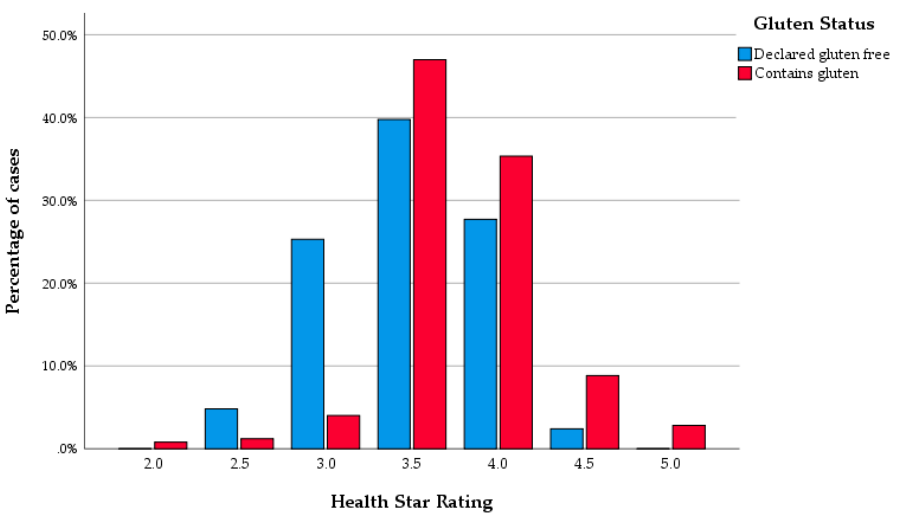
Figure 2. Health Star Rating of products according to gluten status.